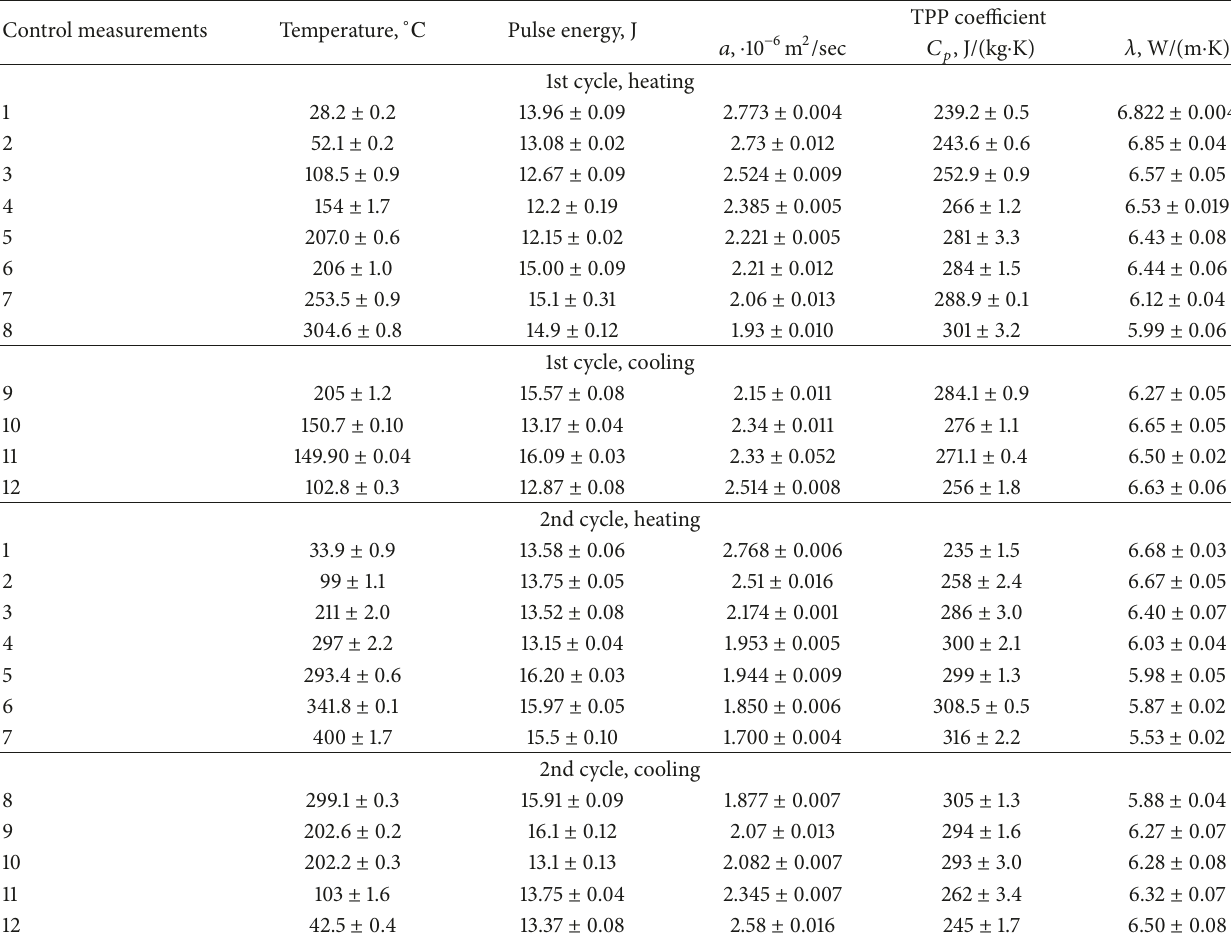
Table 9: The results of TPP measurements of corium sample number 2 within the temperature range from 30 ∘ C to 400 ∘ C. Control